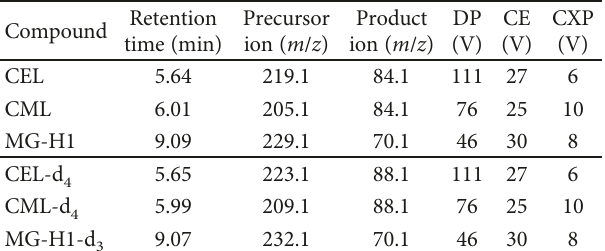
Table 2: Operating parameters for serum AGE measurement using a QTRAP 5500 mass spectrometer equipped with an electrospray ion source operating in the positive ion